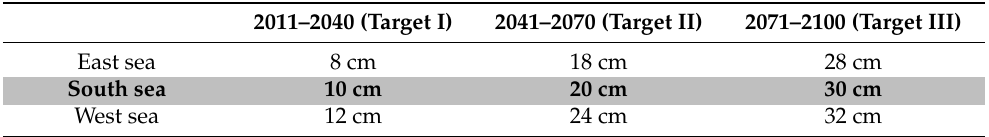
Table 7. Predicted potential sea-level rise rate for the oceans around South Korea. Changwon City is located near the south sea (grey)